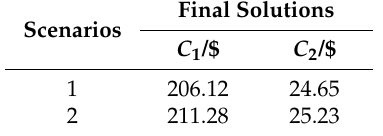
Figure 13. Results of heat power. 6. Conclusions This paper presents a flexible CHP ‐ based MG system, which is connected to both the electric power distribution network and the district heating network, and thus it can exchange not only electricity with the distribution network but also heat with the district heating network. A multi ‐ objective optimal dispatch model is proposed to consider both of the economic cost and environmental cost. The MOBCC algorithm is utilized to solve this multi ‐ objective scheduling problem, and the TOPSIS method is adopted to choose the final decision solution. Simulation results demonstrate that the flexible CHP ‐ based MG system can improve the economic operation and reduce the pollutant emission simultaneously. The EB can facilitate the wind power utilization, and the